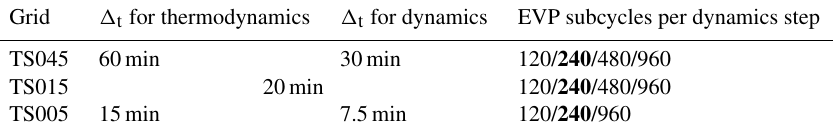
Table 2. Time stepping and EVP configurations; 240 (in bold) is the default value for EVP subcycles for each dynamics step during the long-term spin-up experiments. Other values, including 120, 480, and 960, are also used for the comparative study of modeled sea ice kinematics. (cid:49) t for thermodynamics (cid:49) t for